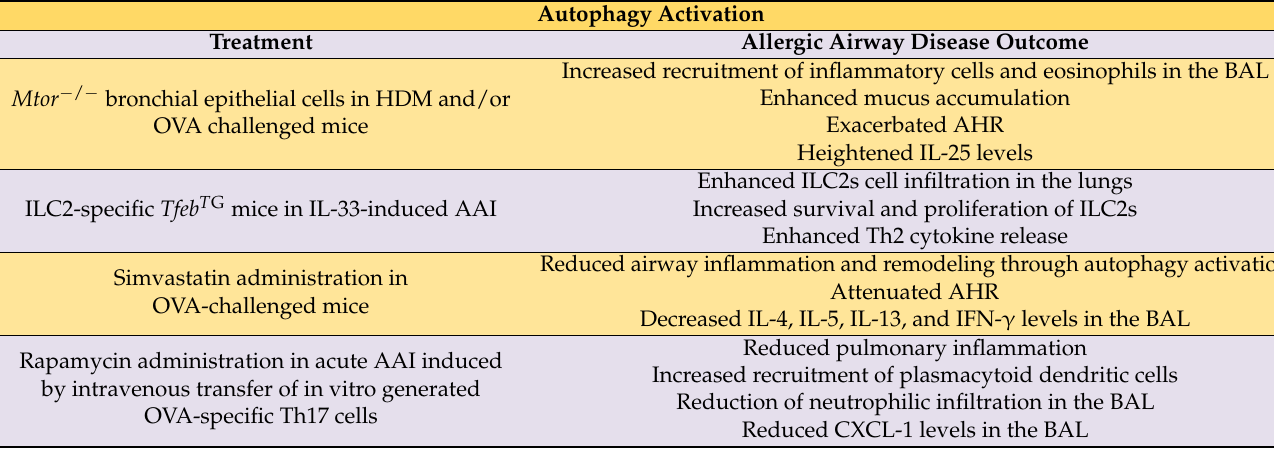
Table 1. Activation of autophagy and its effect on Allergic Airway Disease